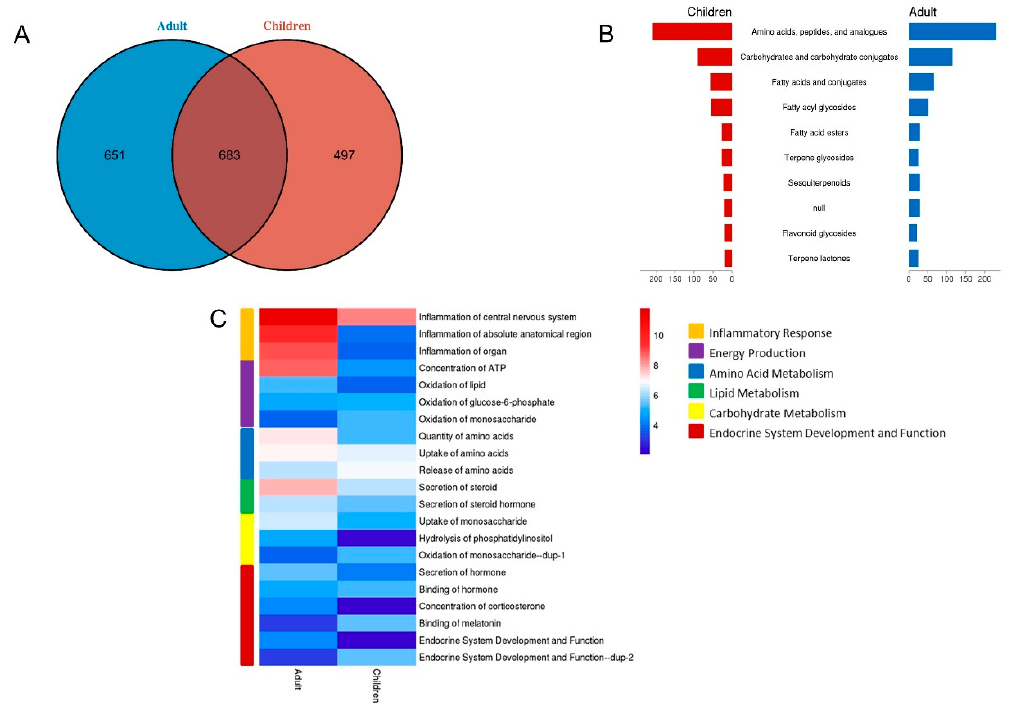
Figure 4. Urine metabolomics comparison between children and adults. ( A ) The overlap between the children’s and adult’s urinary metabolites. ( B ) Chemical class of the urinary metabolites from children and adults. ( C ) Functional comparison of the urinary metabolites from children and adults.